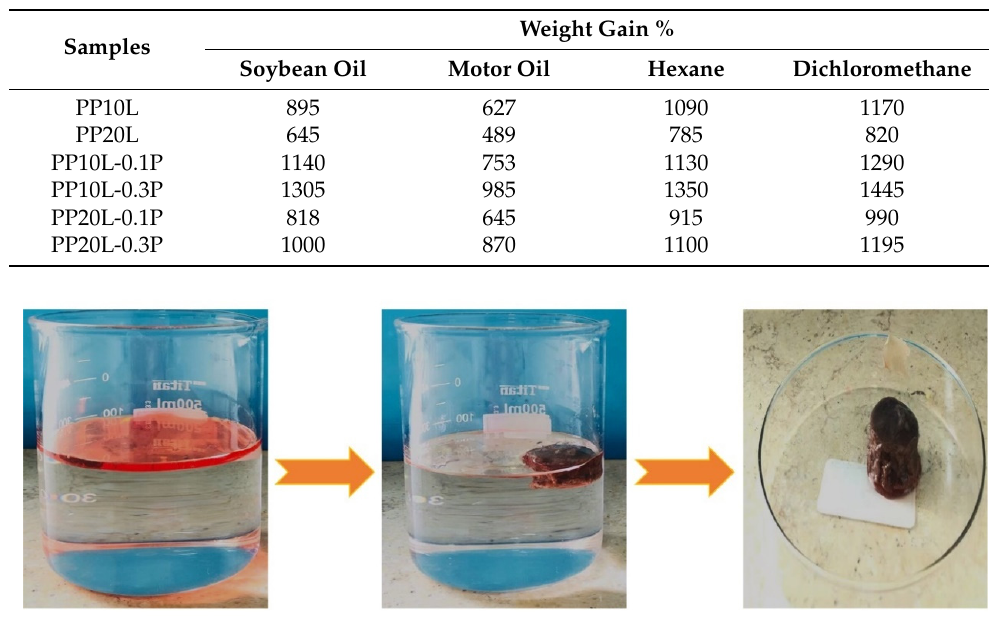
Figure 12. Photographs of the sorption process of soybean oil by sponge PP10L-0.3 P.